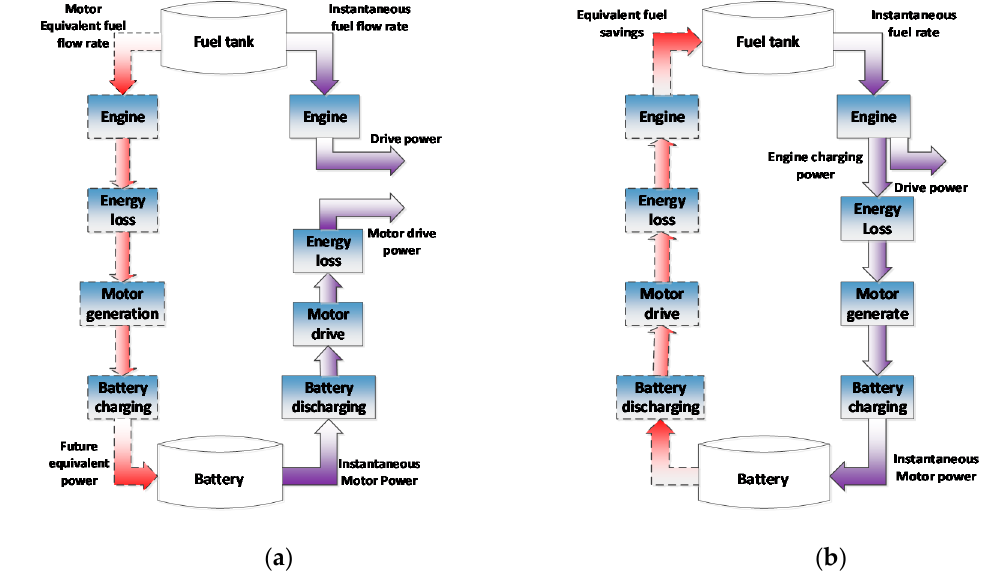
Figure 7. The energy path during charge and discharge in a parallel hybrid electric vehicle (HEV): ( a ) battery discharging; ( b ) battery charging [95].